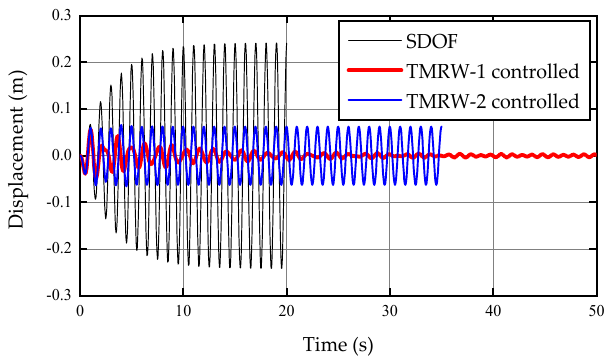
Figure 5. Comparison of displacement responses with and without TMRW.